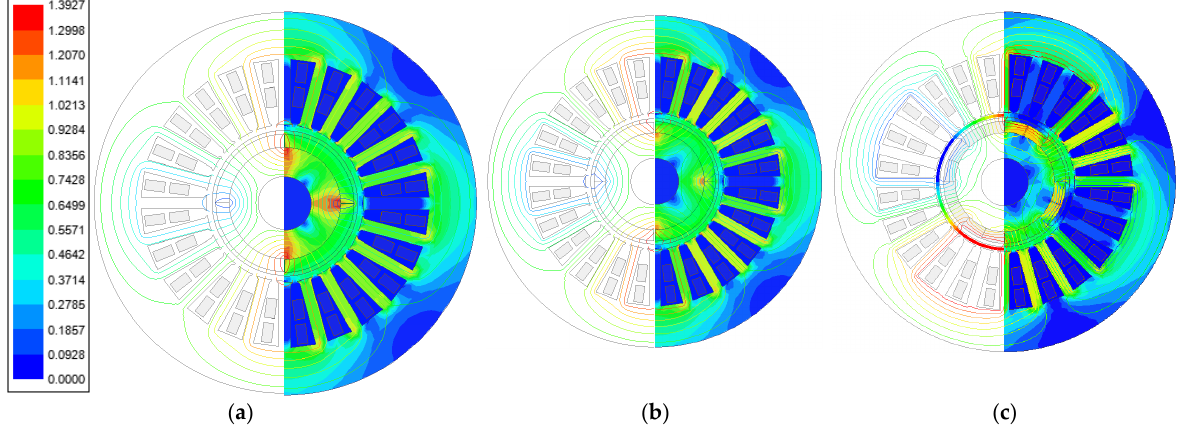
Figure 7. PM magnetization methods. ( a ) Radial magnetization; ( b ) parallel magnetization; ( c ) Halbach magnetization.